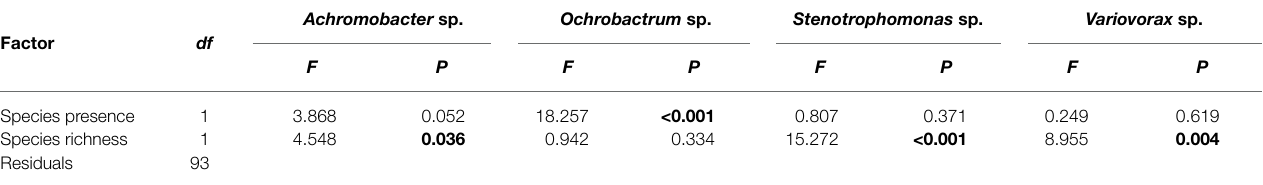
Species presence